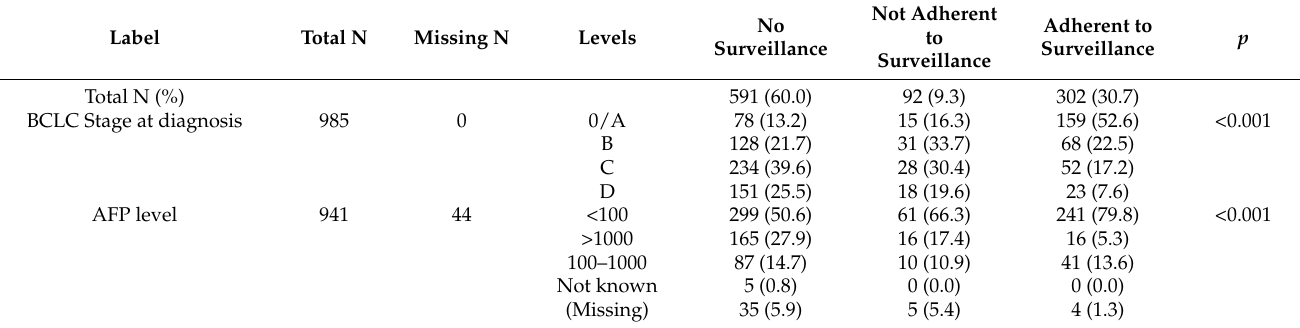
Table 3. Stage of disease and subsequent therapy by surveillance adherence